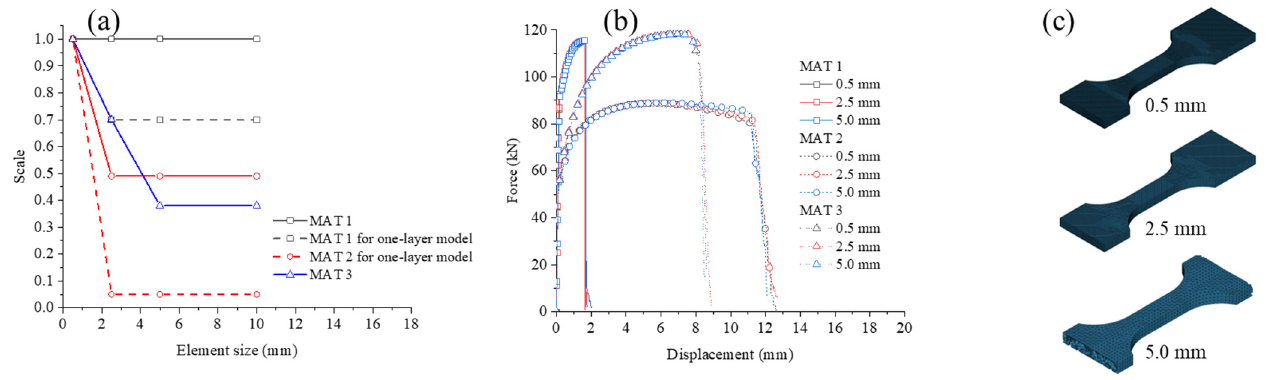
Figure 16. Mesh-dependency regularization factors for tetrahedral-based models: ( a ) Mesh depen- dency regularization factors, ( b ) Simulation results, and ( c ) Tensile specimen models with different mesh sizes.